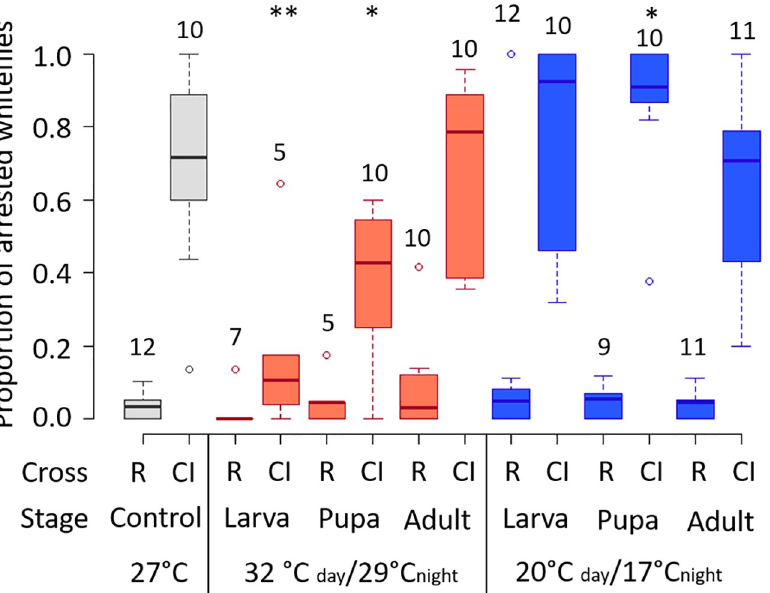
Fig 2. Proportion of arrested whiteflies (proxy for CI-mortality) generated from crosses involving male wasps exposed to different temperatures. Color of bars denotes temperature range (grey = 27˚C, red = 32–29˚C, blue = 20–17˚C). Treatments are also separated by the stage at which the temperature exposure began. R = rescue cross, C+ female x C+ male. CI = CI cross, C- female x C+ male. Asterisks denote significant differences compared to crosses of the same type performed at 27˚C. Numbers above whisker plots denote replicate number. N = 5–12 males, with a mean offspring per male =